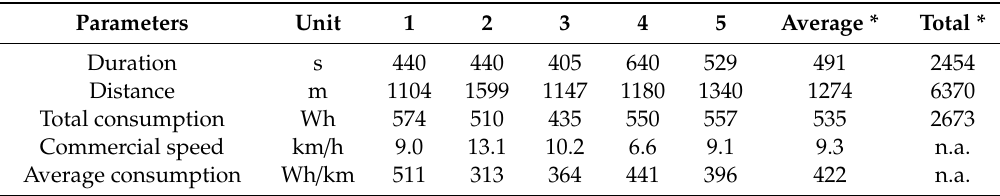
Table 2. Road testing results of P2.